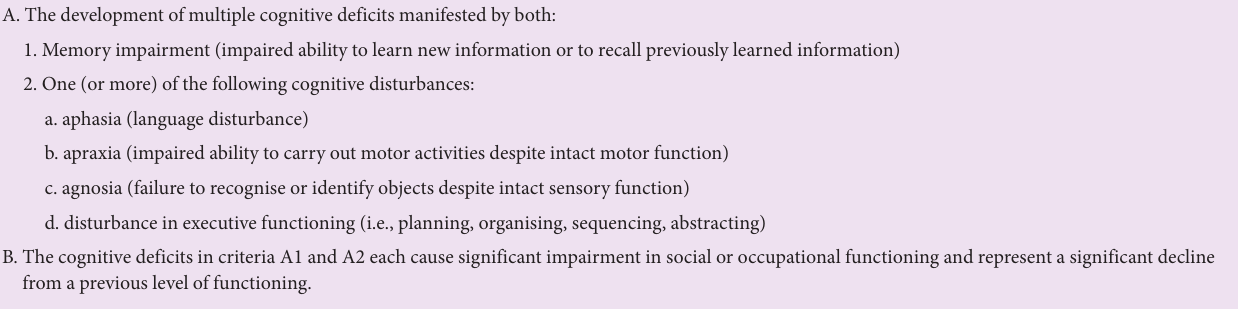
Table 1. Diagnostic criteria for dementia of the Alzheimer’s type [11]